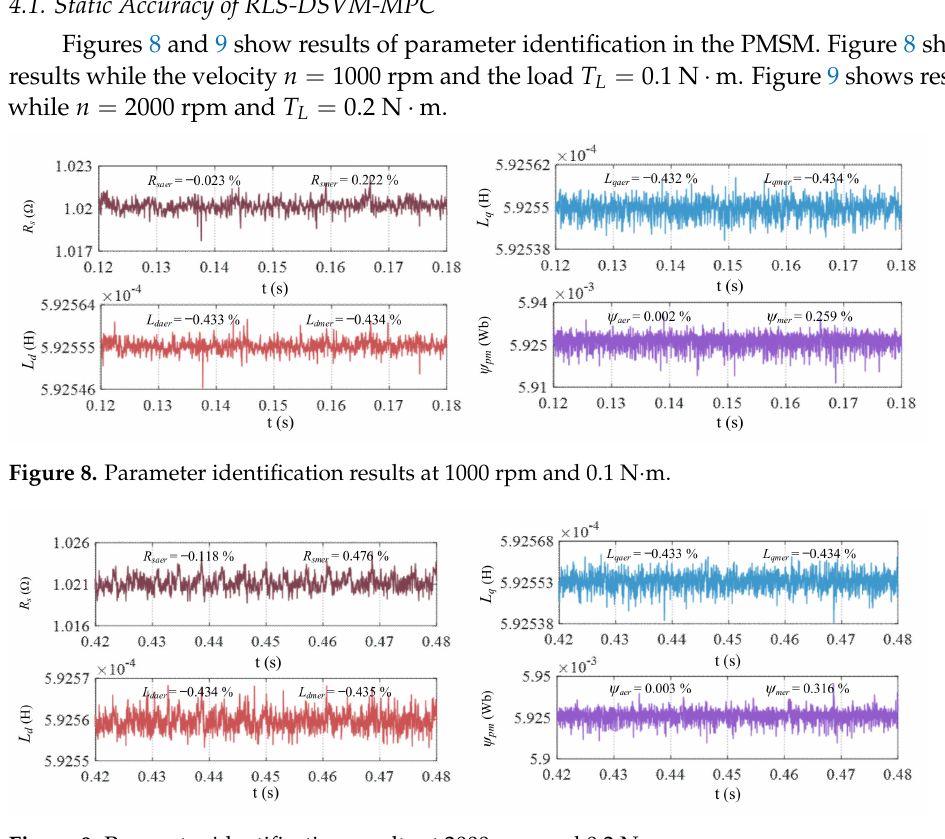
Figure 9. Parameter identification results at 2000 rpm and 0.2 N ·